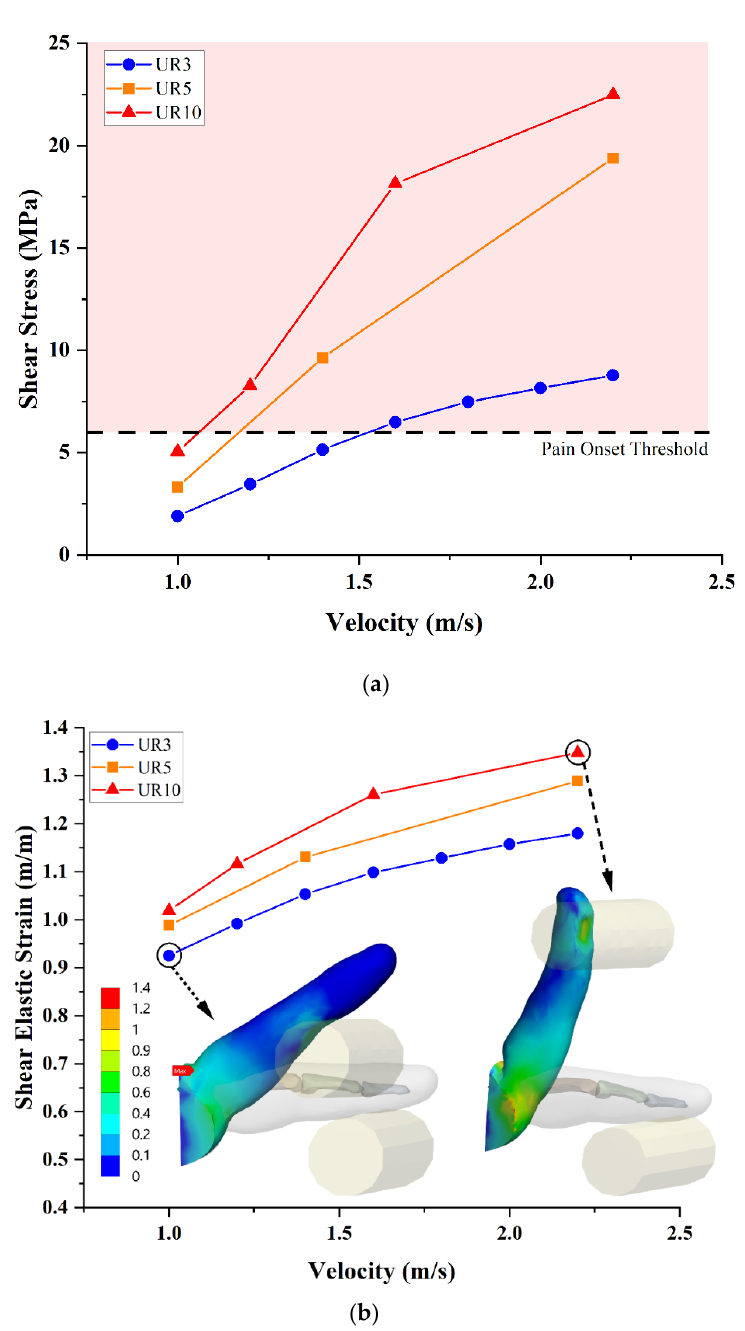
Figure 5. Hyperextension as a function of end effector velocity and robot effective mass, with contour results at the points shown: ( a ) Maximum Shear Stress; ( b ) Maximum Shear Elastic Strain.